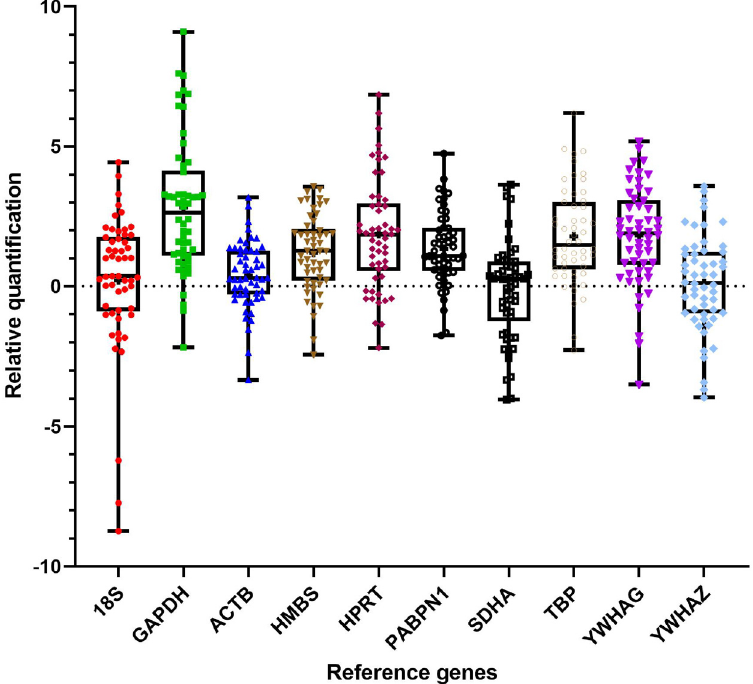
Fig 1. Relative quantitation of reference genes. Δ Cq values for reference genes in a representative experimental run. Whiskers are 2.5% - 97.5% and ‘+’ denotes the arithmetic mean of Cq values for that reference